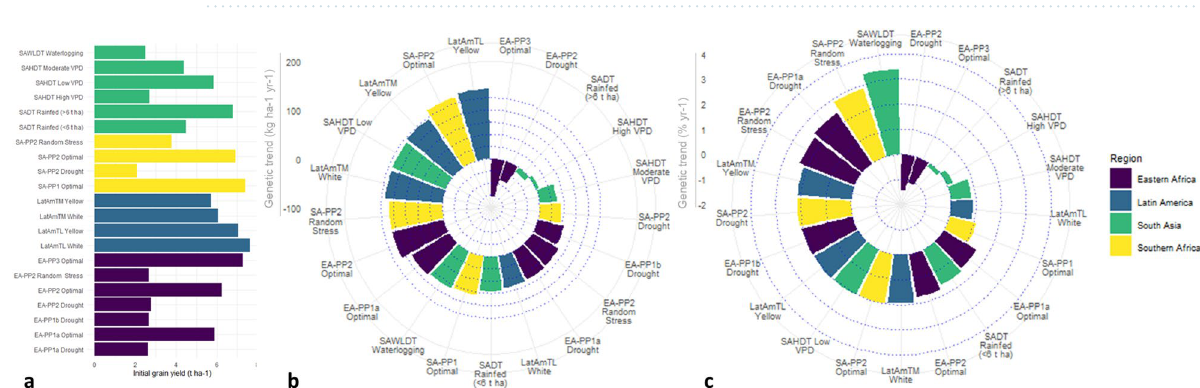
Figure 3. Repeatability of individual trials in various product profiles by abiotic stress management.